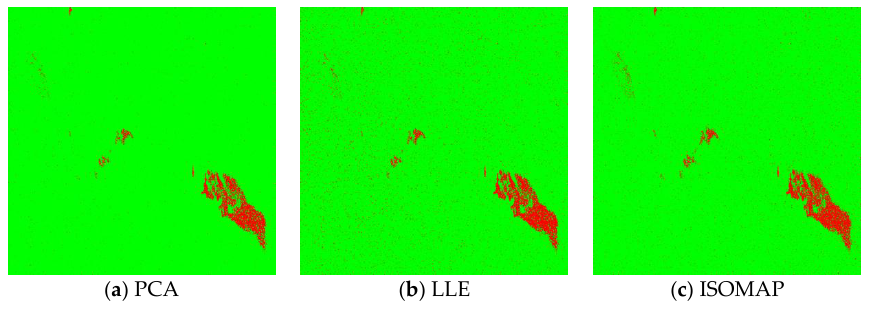
Figure 8. Classification results using SVM based on feature dimension reduction methods. Table 12. Confusion matrix achieved by SVM based on four features derived from PCA on quad-pol SAR features.